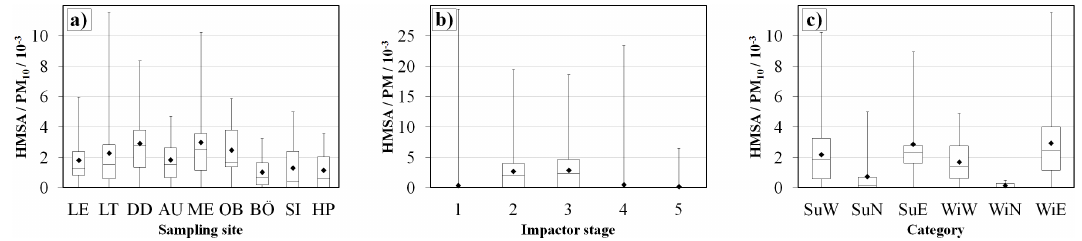
Fig. 4. (a) Fraction of HMSA in PM 10 (sum of impactor stages 1–5) as a function of the sampling site. (b) Fraction of HMSA in PM as a function of the particle size. (c) Fraction of HMSA in PM 10 (sum of impactor stages 1–5) as a function of the meteorological category. The symbols and numbers of samples are consistent with Fig. 3. See text for